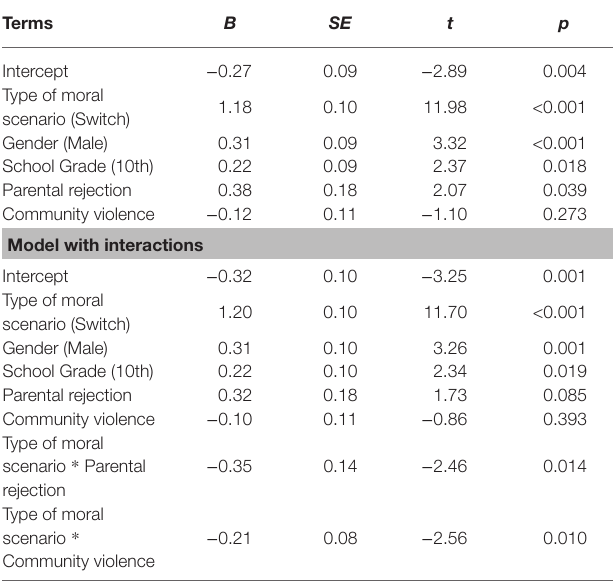
TABLE 2 | Generalized linear mixed model (2) – Contextual-related factors predicting No/Yes answers in moral